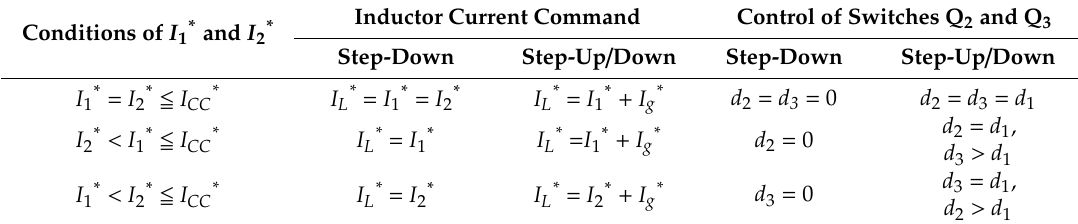
Figure 9. Block diagram of the equalized charging controller, where k = 1,2 and j = 2,3, ( a ) the dual-loop controllers of charging two batteries, ( b ) the inductor current controller. Table 1. Inductor current command determination criteria.